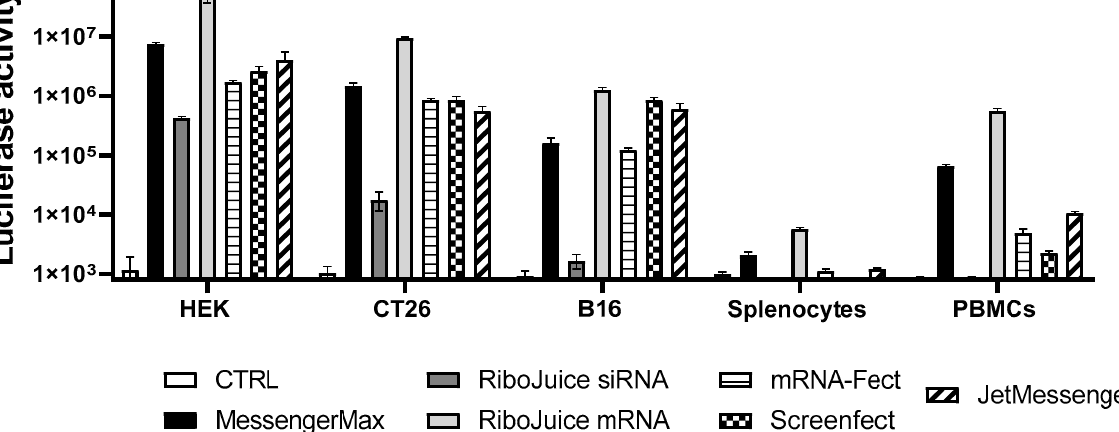
Figure 1. Transfection efficiency of various commercially available transfection reagents. Established human and murine cell lines were transfected with 20 ng mRNA coding for firefly luciferase, whereas primary human PBMCs and murine splenocytes were transfected with 100 ng mRNA. These doses were found as optimal with regard to transfection efficiency and toxicity (Figure S1). Non-transfected cells of each cell type served as the negative control group (CTRL). Luciferase activity was measured 24 h post transfection in a white 96-well plate. Data represent triplicate mean values; error bars: SD.